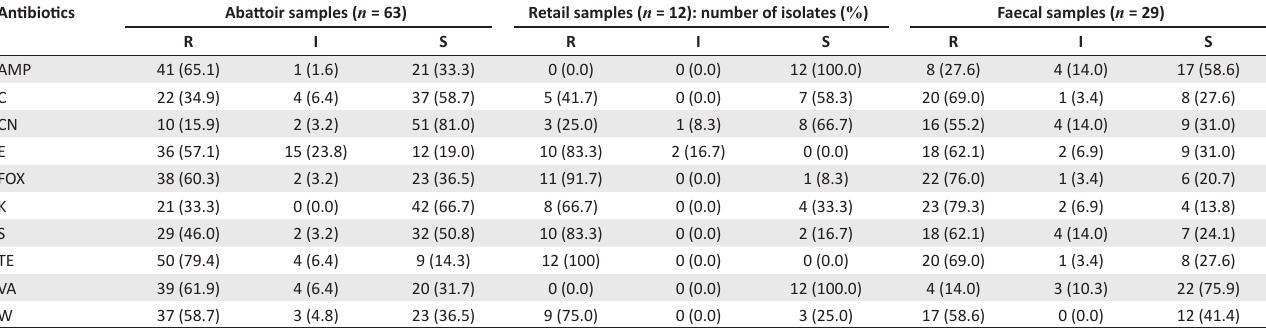
TABLE 2: Prevalence rates for antimicrobial susceptibility tests on Staphylococcus aureus isolated from broiler chicken samples of different origins. Antibiotics Abattoir samples ( n = 63) Retail samples ( n = 12): number of isolates ( % ) Faecal samples ( n = 29)